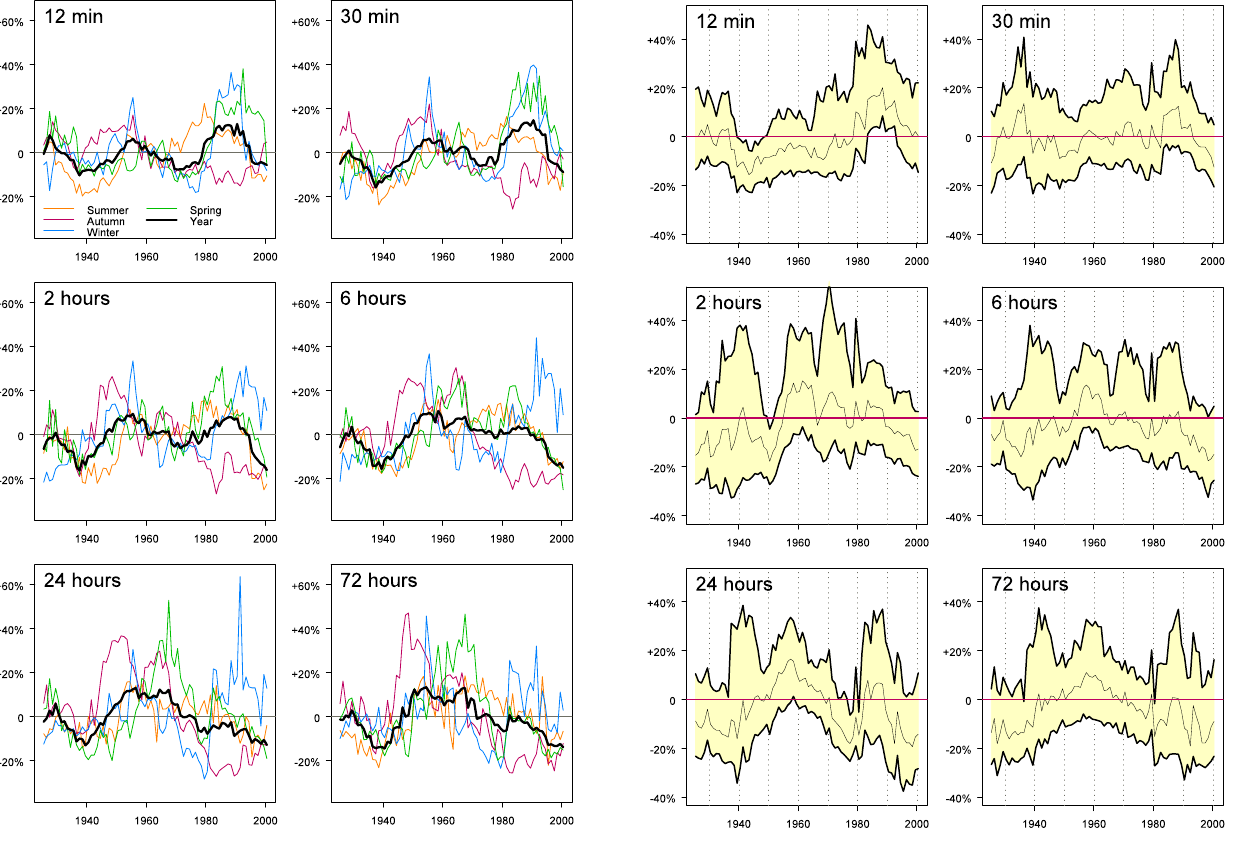
Fig. 5. 90% confidence intervals for percentage differences be- tween quantile estimates for 10-yr sliding windows and the long- term average based on